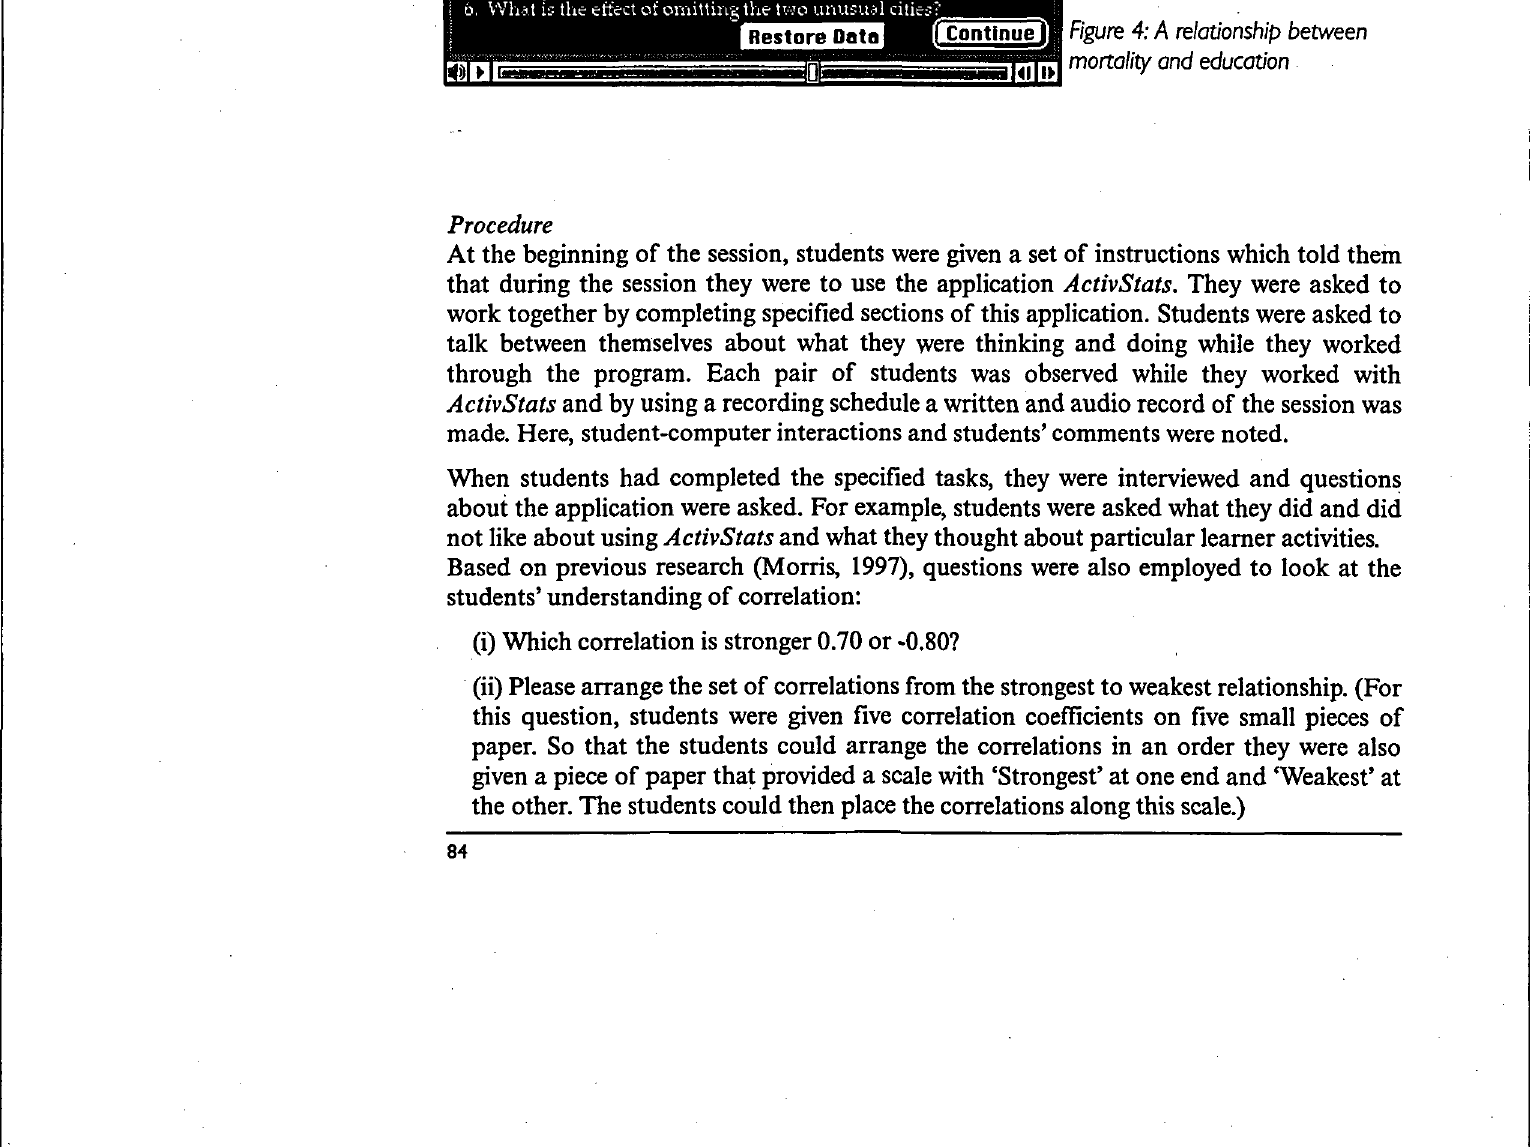
Figure 4: A relationship between mortality and